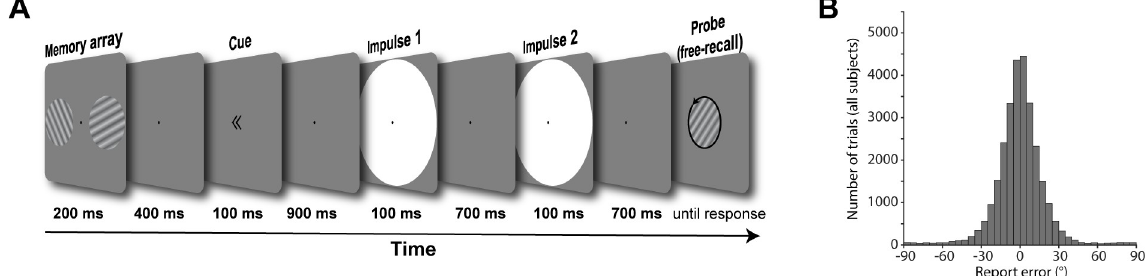
Fig 2. Trial schematic and behavioural results. (A) Two randomly orientated grating stimuli were presented laterally. A retro-cue then indicated which of those two would be tested at the end of the trial. Two impulses (white circles) were serially presented in the subsequent delay period. At the end of the trial, a randomly oriented probe grating was presented in the centre of the screen, and participants were instructed to rotate this probe until it reflected the cued orientation. (B) Report errors of all trials across all participants. Data available at osf.io/cn8zf.